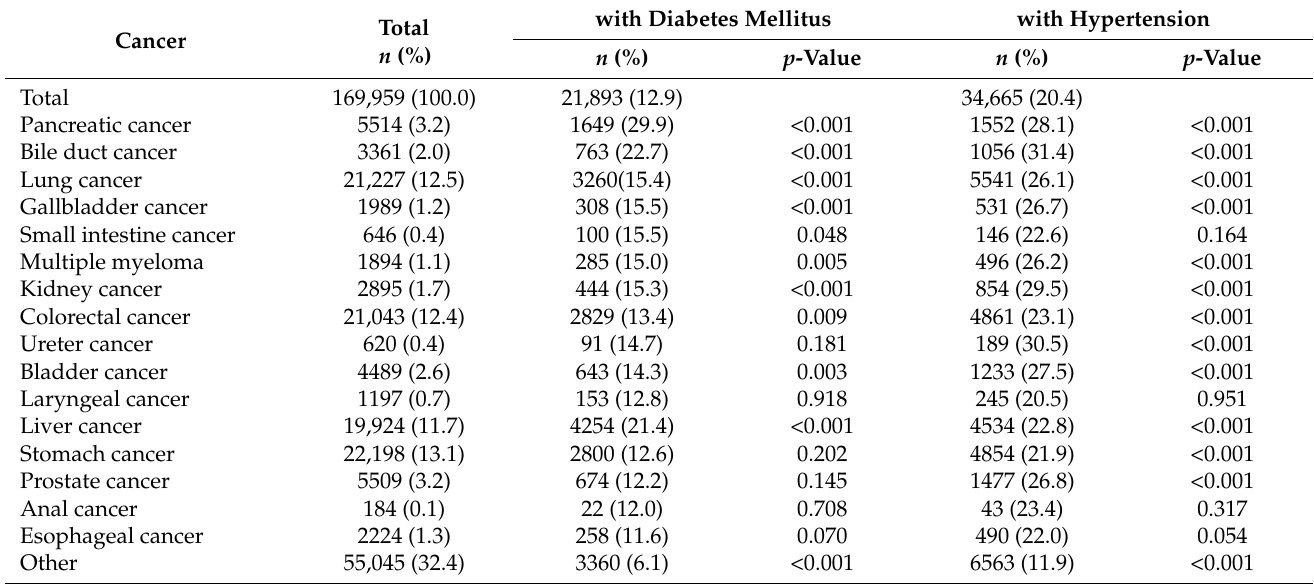
Table 2. Prevalence of diabetes mellitus and hypertension among patients with major cancers.